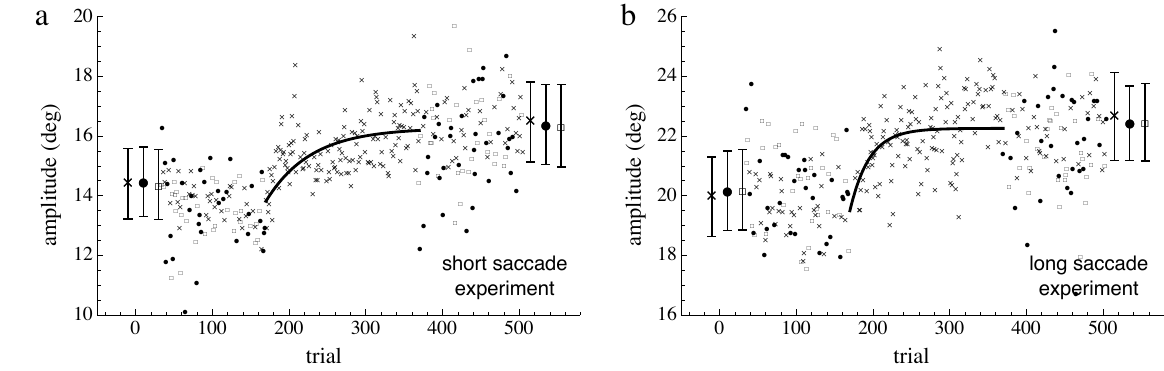
Figure 6 . Examples of adaptation over an individual session in the short saccade (a) and long saccade (b) experiment. The figures show saccade amplitude as a function of trial number. Crosses indicate the pure saccade trials (pure adaptation and standard saccade), filled circles indicate the target on localization trials and open squares indicate the target off localization tri- als. The large symbols on the edges of each figure indicate the mean saccade amplitude over all subjects in the pre-adaptation (left edge) and post-adaptation (right edge) phases. Error bars are standard deviations